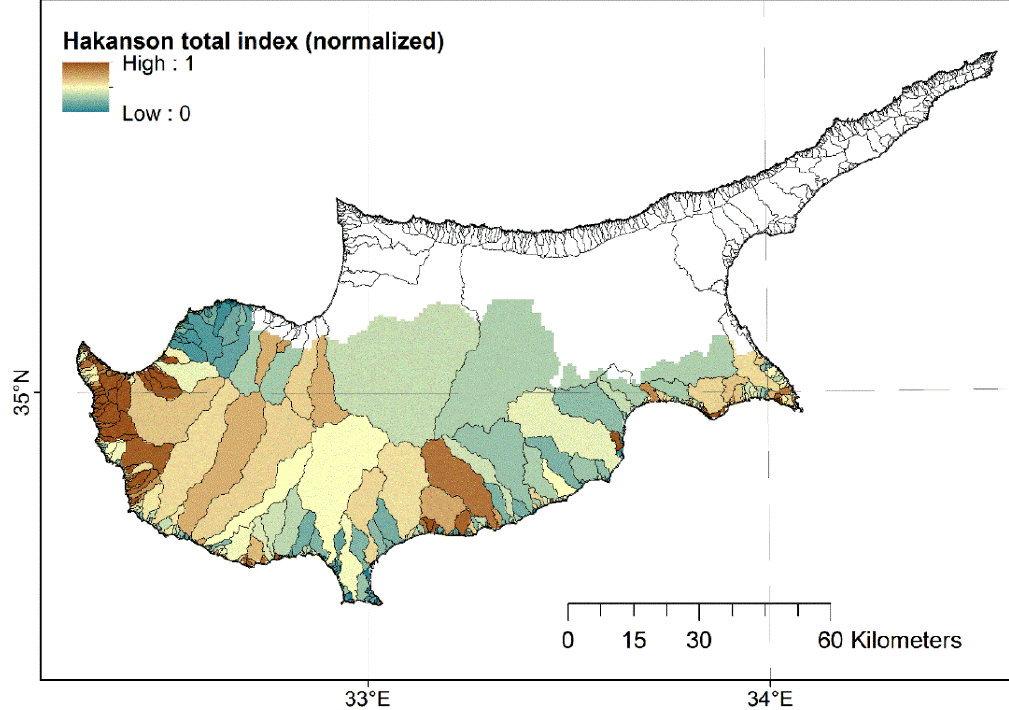
Figure 8. Choropleth map of the Hakanson index for total risk per basin (value ranging: histogram equalization; mean value: 37.1; normalized mean value: 0.22).